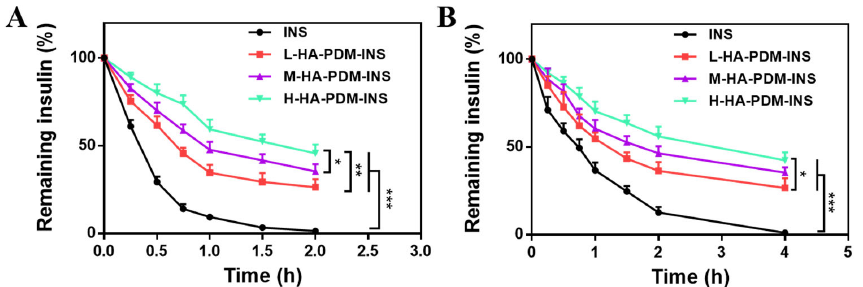
Figure 4. Stability profiles of the associated insulin after incubation of simulated gastric fluid containing pepsin (pH 1.2) ( A ) and simulated intestinal fluid containing trypsin (pH 7.4) ( B ) at 37 °C for various time points (X ± SD, n = 3, * p < 0.05, ** p < 0.01, *** p < 0.001).